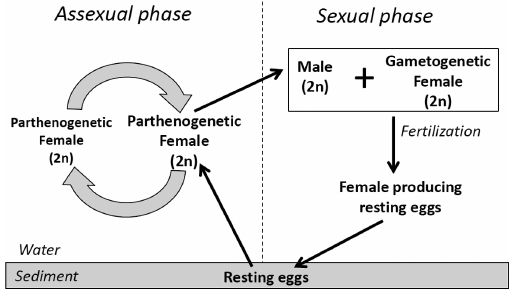
Figure 2. The reproductive cycle of cladocerans (After De Meester et al.,